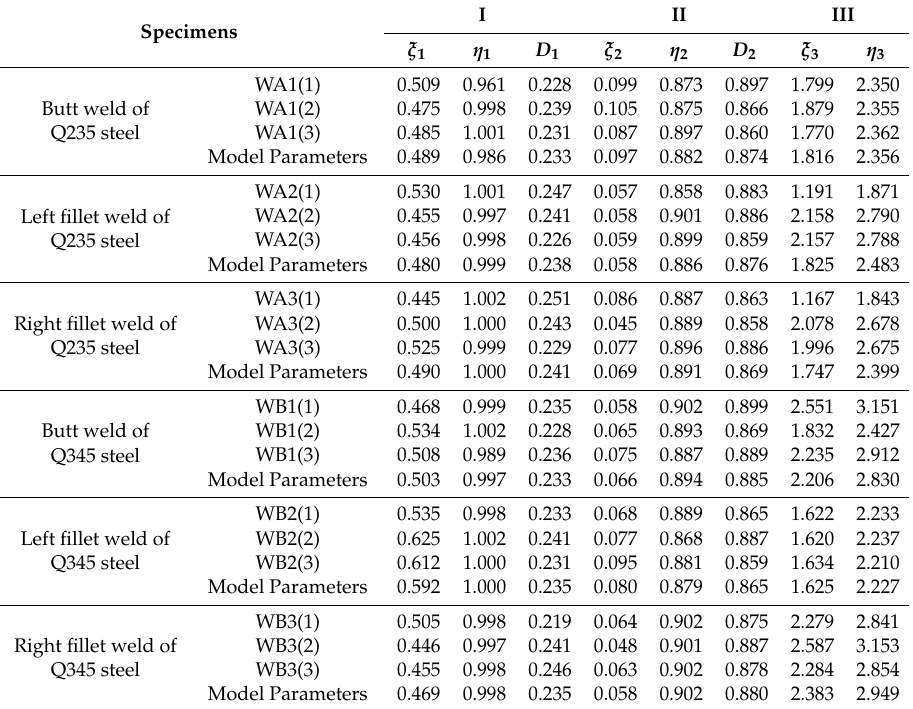
Table 7. Values of parameters η , ξ .